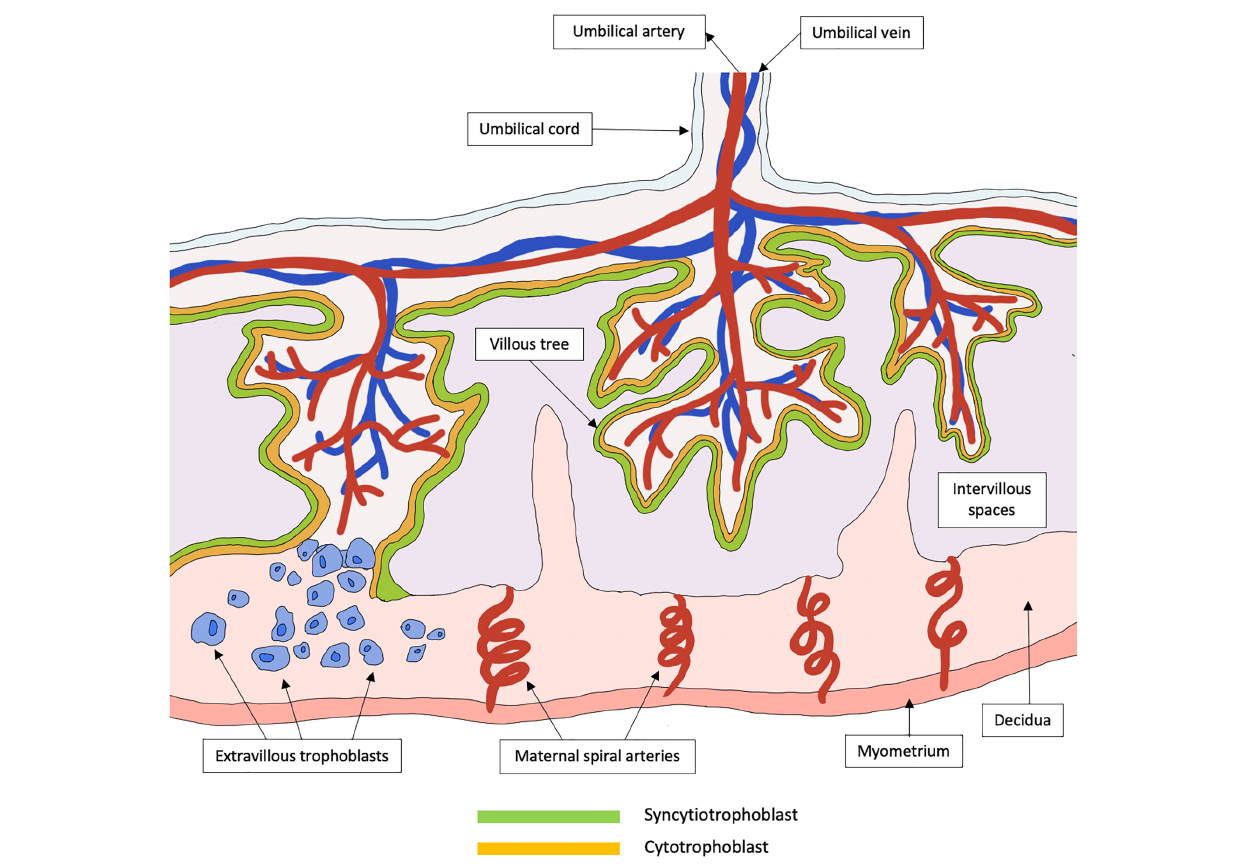
FIGURE 1 | Schematic representation of a healthy functional unit of the human placenta. The placenta is a specialized organ that is primarily involved in the exchange of metabolites between the mother and her fetus. In the early trimester, the trophoblast differentiates to form primary syncytium that further divides into the cytotrophoblast and syncytiotrophoblast. The syncytiotrophoblast will then expand to form a continuous layer of tree-like villous that are in contact with maternal blood in the intervillous spaces. These villous trees greatly increase the surface areas available for the exchange of metabolites. Cytotrophoblasts can further differentiate into extravillous trophoblasts that invade the decidua, which is the maternal uterine tissue, to promote immune tolerance between the mother and her fetus. The extravillous trophoblasts also migrate up the maternal spiral arteries and promote spiral artery remodeling, to form large vessels of low resistance that is required to sustain a healthy